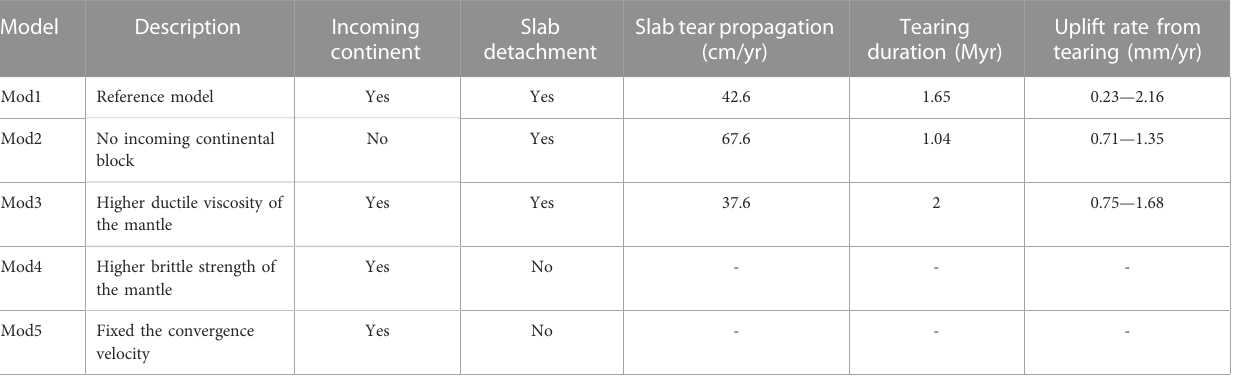
TABLE 2 Comparison between model